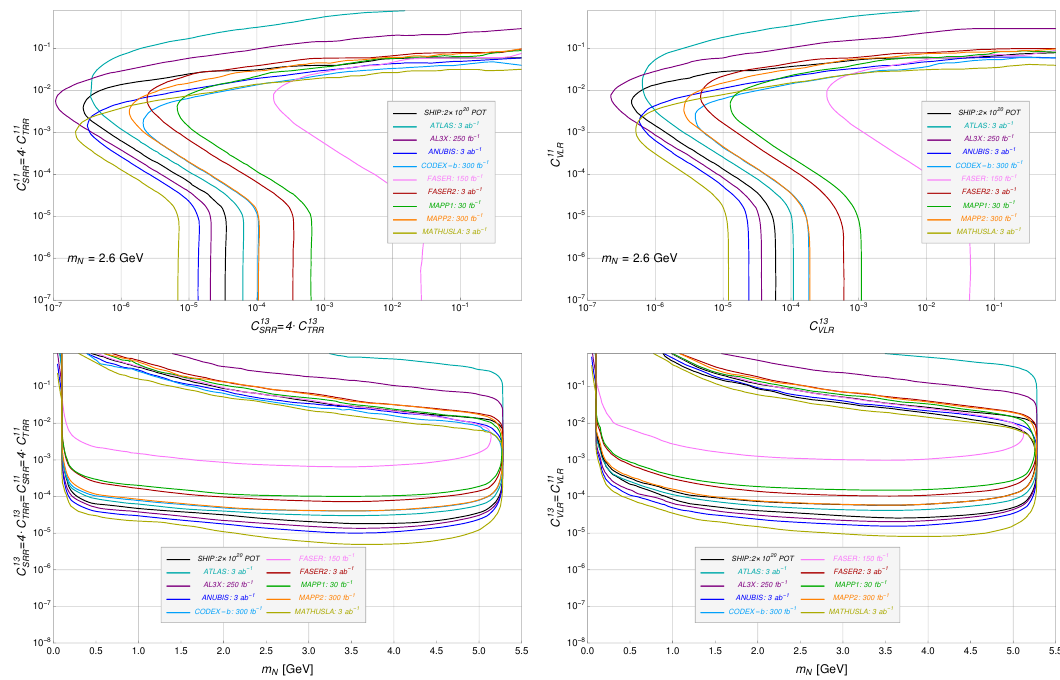
Figure 9 . Results for (cid:13)avor benchmark 3. The scenarios and the labeling are as in (cid:12)gure